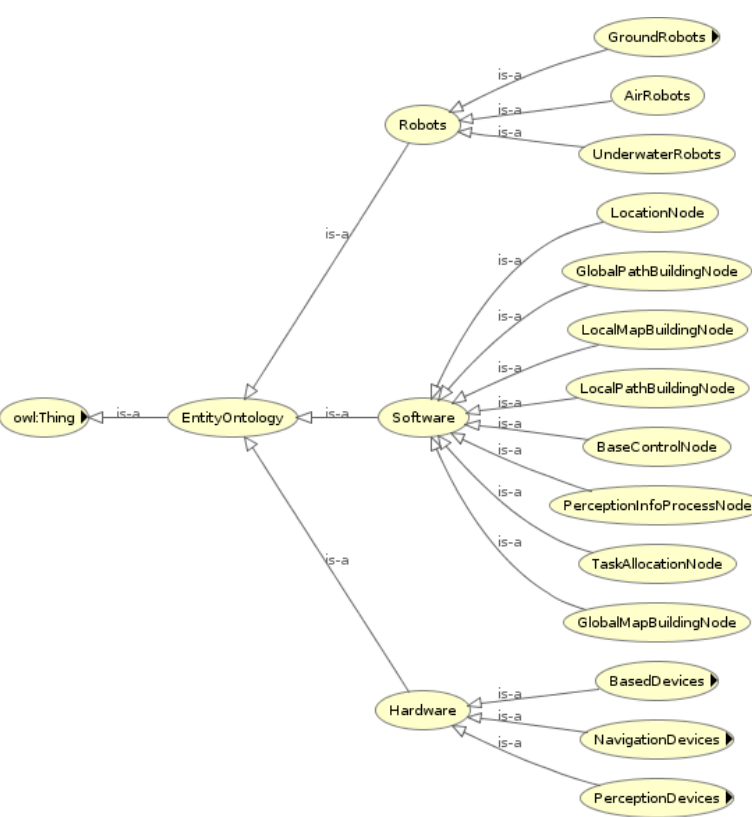
Figure 4. The entity ontology is shown in Prot é g é .